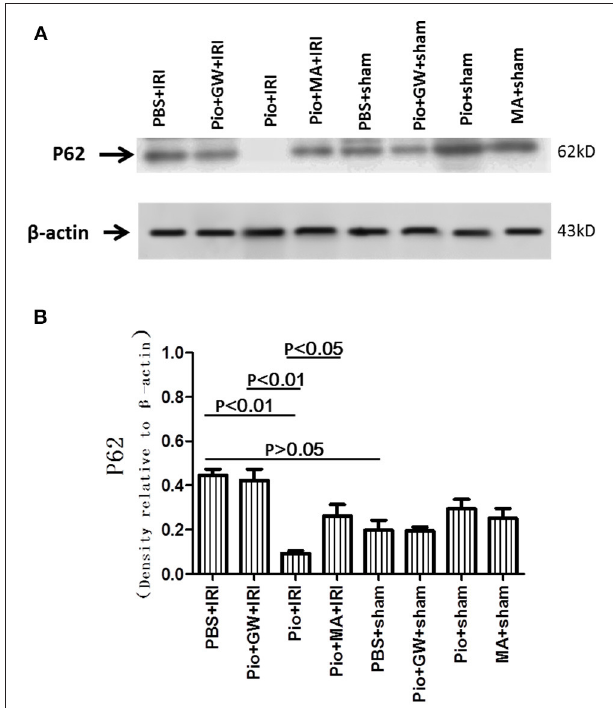
FIGURE 9 | Pioglitazone decreases p62 protein in renal tissue at 24h after renal IRI. (A) Representative western blots show p62 protein level in the kidneys. (B) Quantitative analysis of p62 protein level in the kidneys. Values are expressed as means ± SE (B) . n = 6 in each